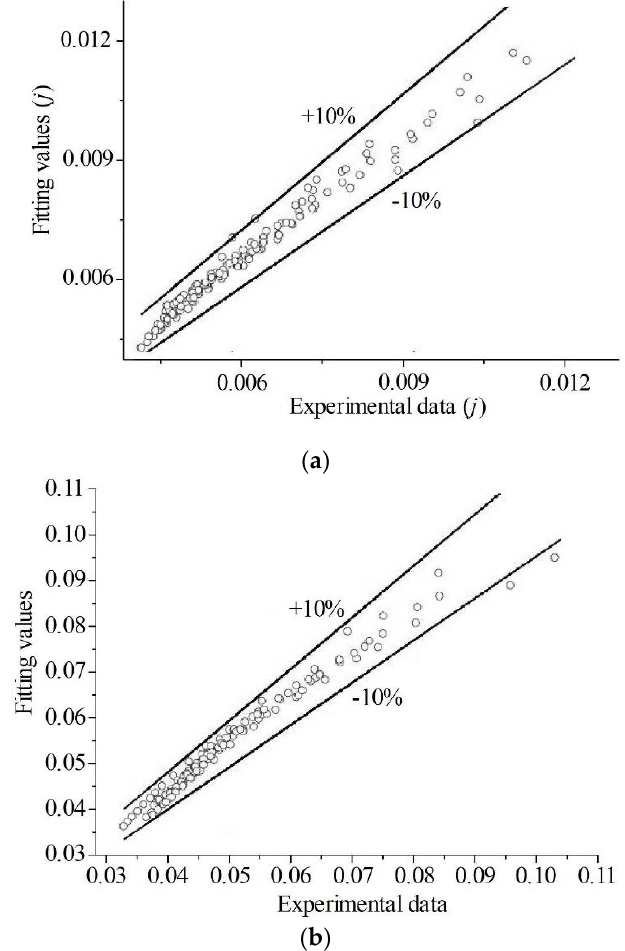
Figure 8. Comparison between the fitting values of the correlation expressions of factor j and factor f and the experimental data. ( a ) factor j ; ( b ) factor f .